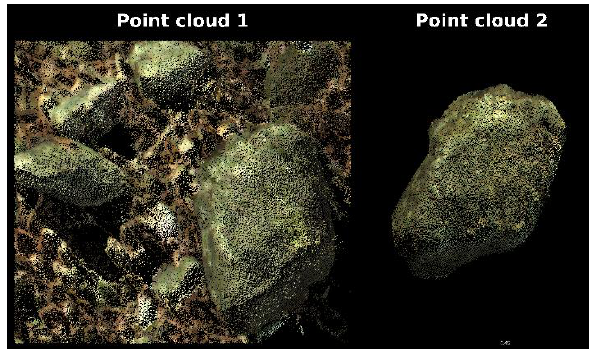
Figure 1. Example of terrestrial laser scanning point clouds under registration; reference point cloud – point cloud 1; aligned point cloud – point cloud